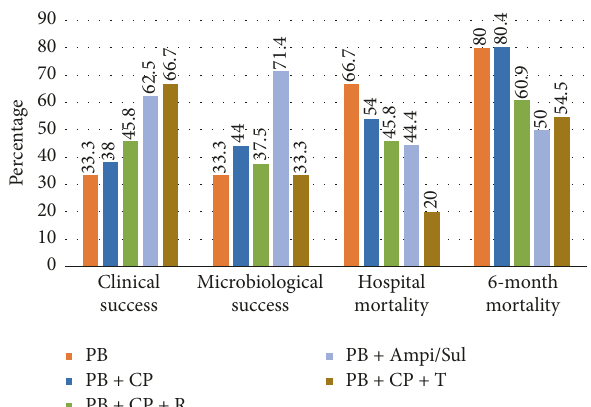
Figure 3: Comparison of polymyxin B combination treatments in different outcomes [45]. PB: polymyxin B, CP: carbapenem, R: Rifampin, Ampi/Sul: Ampicillin/Sulbactam, and T: Tigecycline.